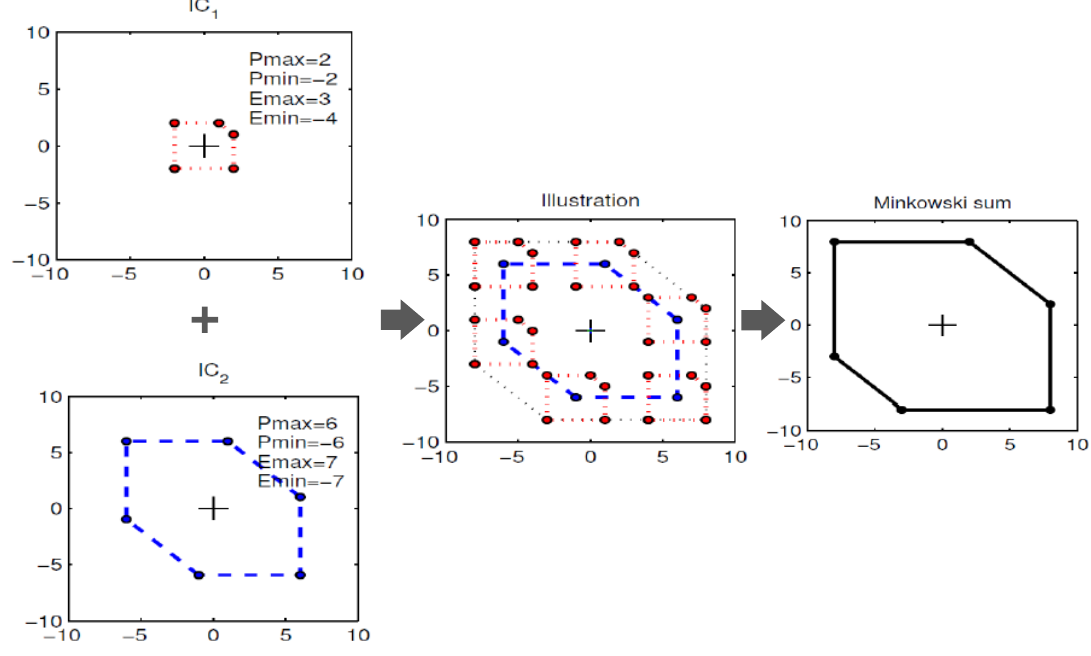
Figure 5. Minkowski summation of two resource polytopes for a two-sample horizon ( P and E refer to power and energy limitations, respectively) (adapted from [49]).